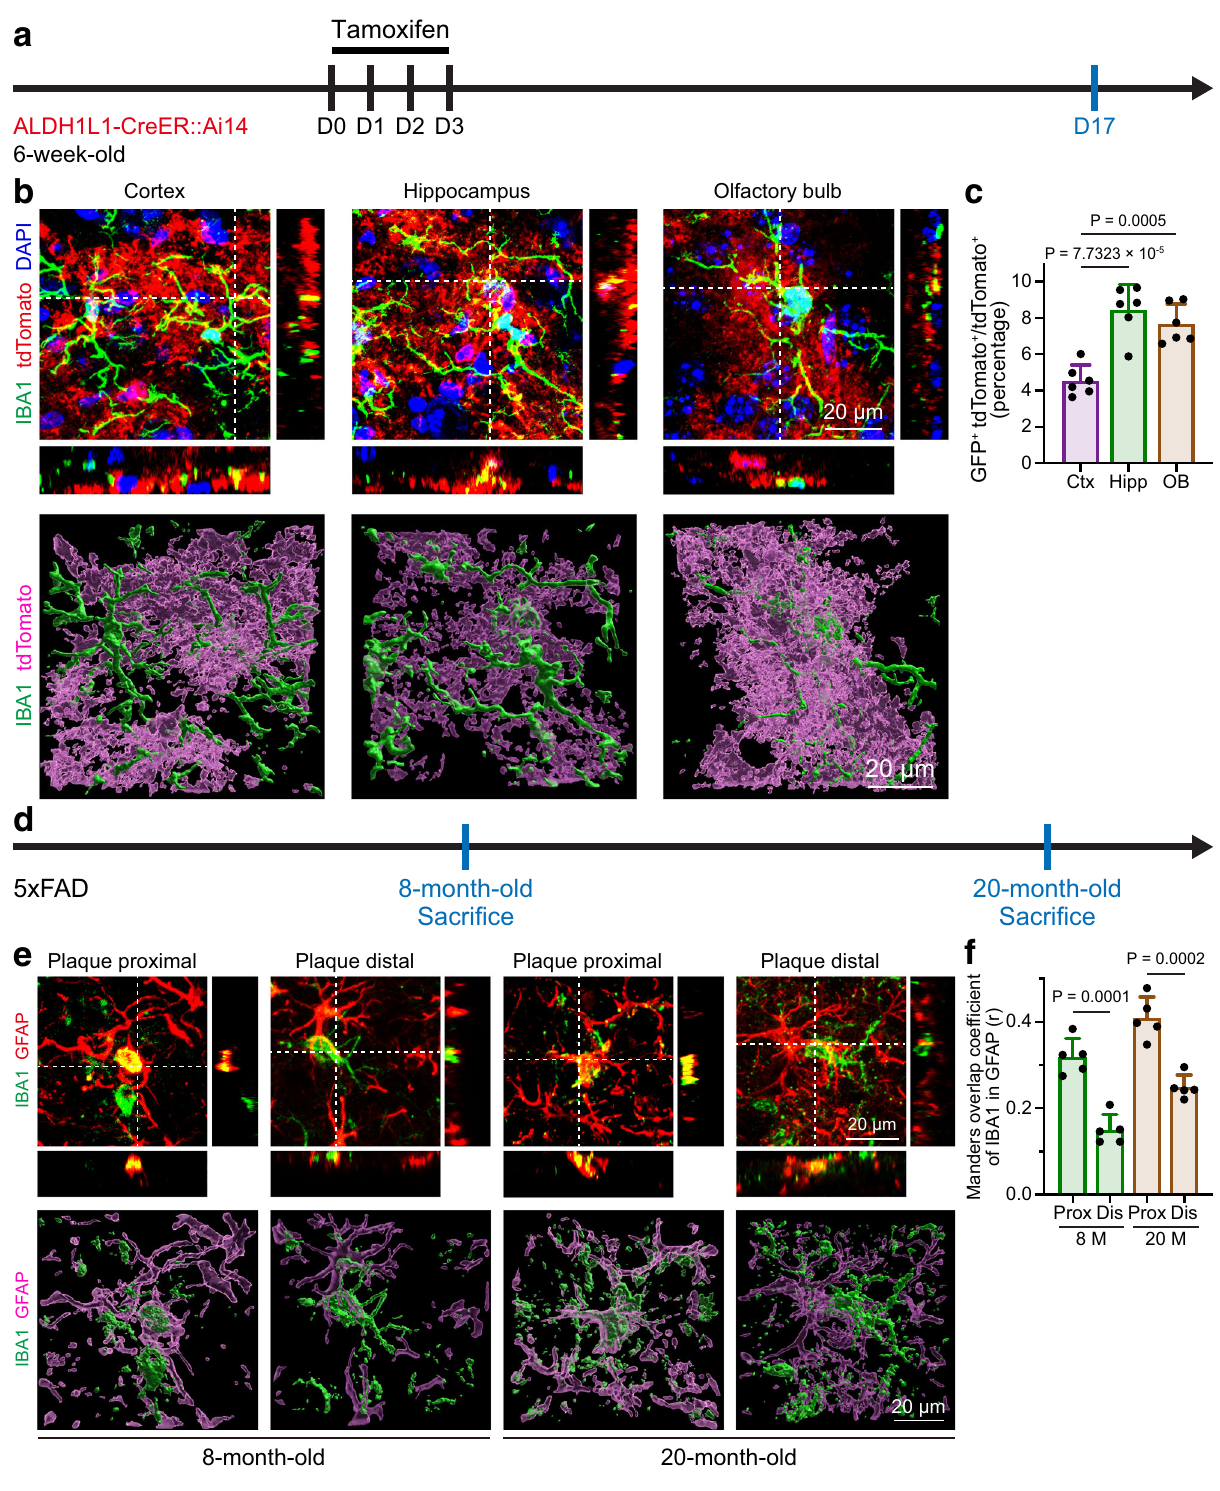
Fig. 3 | The astrocytic engulfment of microglial debris is positively correlated with the speed of microglial turnover under both physiological and patholo- gical conditions in vivo. a Scheme of the in vivo examination of astrocytic engulfment in different brain regions of ALDH1L1-CreER::Ai14 mice under physiological conditions. b , c Astrocytes in the cortex engulfed less micro- glial debris than those in the hippocampus and olfactory bulb. N =6 mice for each group. One-way ANOVA with Holm ‒ Sidak ’ s multiple comparisons test (post hoc). The quantitative results ( c ) show the results from the reanalysis